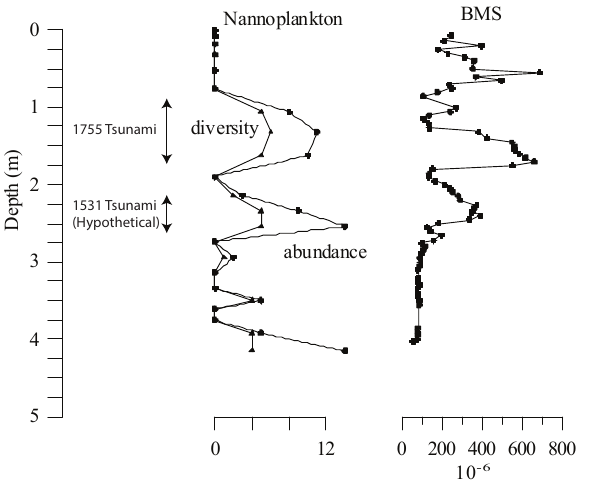
estuary; Bottom: Detail of the built environments at Alcan-